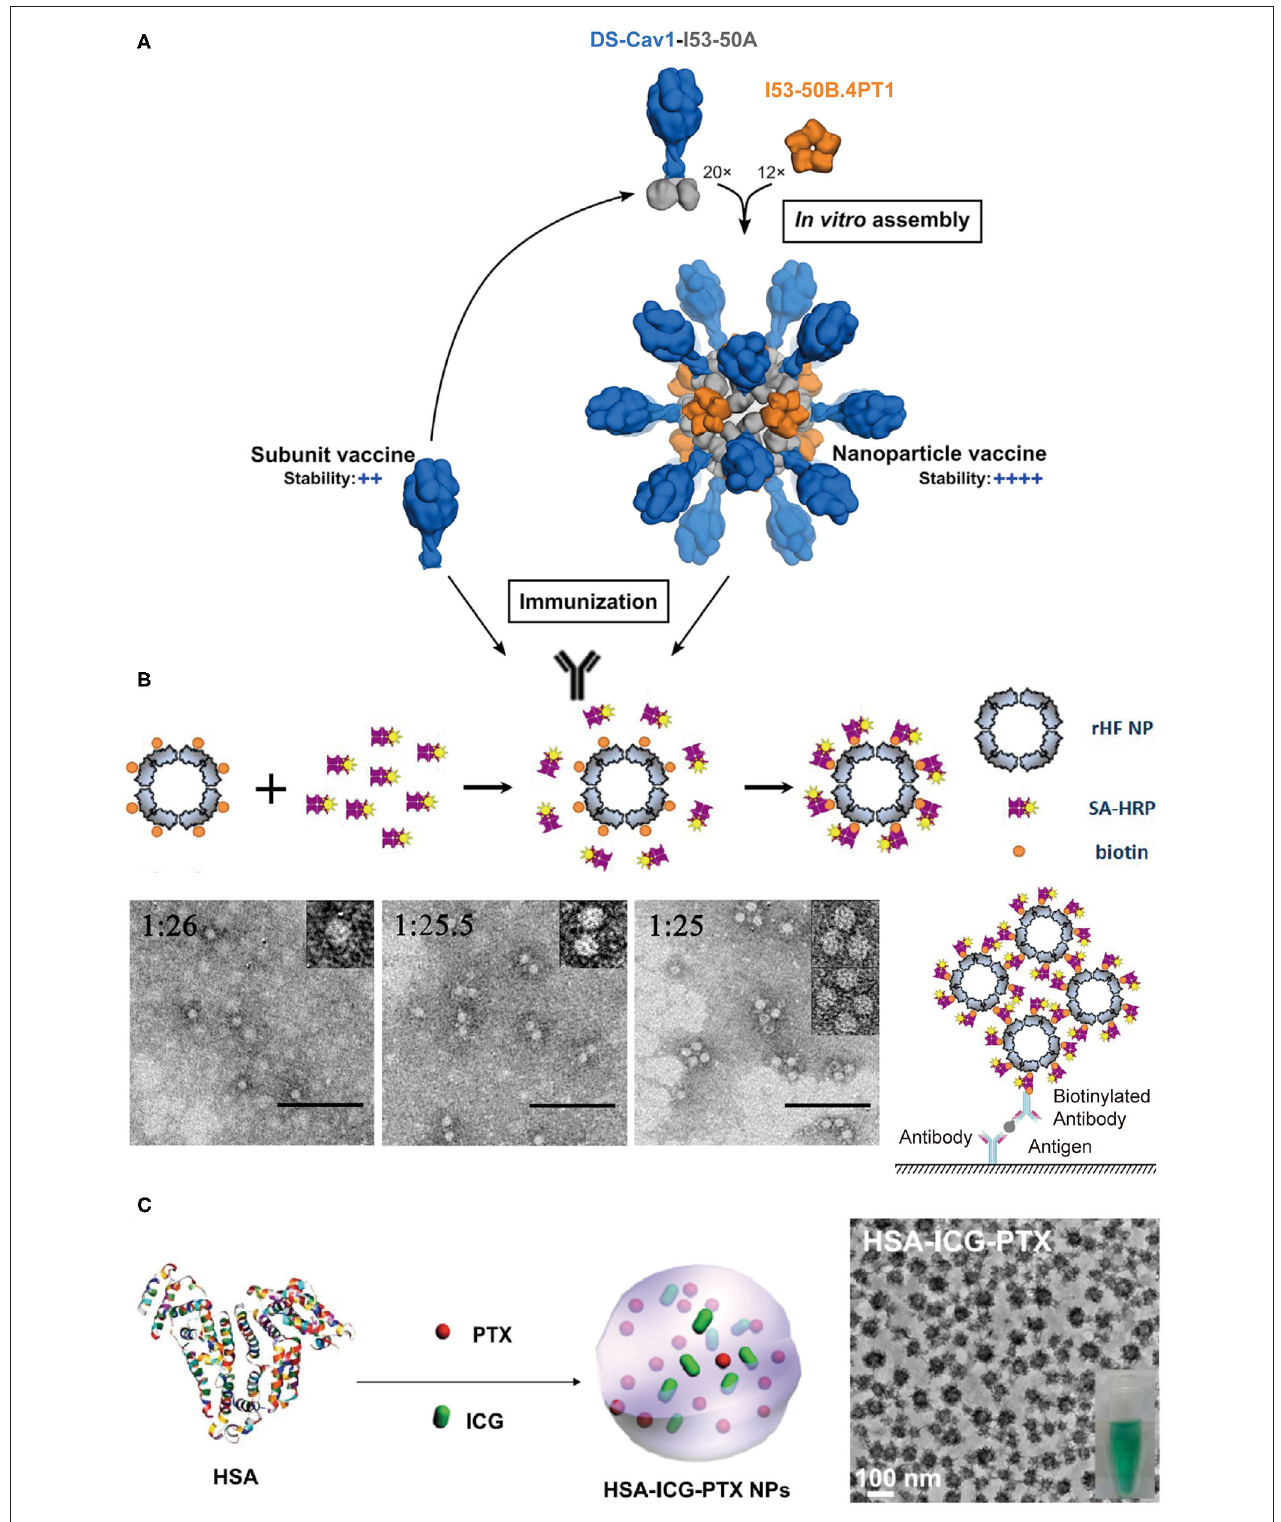
FIGURE 8 | Protein assemblies for medical applications. (A) A schematic illustration of the assembly structure of a DS-Cav1 based nanoparticle vaccine. Adapted with permission from Marcandalli et al. (2019). Copyright 2019 Elsevier Inc. (B) The molecular mechanism proposed for the co-assembly of ENC (top) and the particle geometry of ENC observed in TEM images with different molar ratios of rHF NP to SA-HRP of 1:26, 1:25.5, and 1:25, respectively (bottom). The scale bar is 100nm in each TEM images. Reproduced with permission from Men et al. (2015). Copyright 2015 American Chemical Society. (C) A schematic illustration of the formation of HSA-ICG-PTX nanoparticles based on the co-assembly of HSA, PTX, and ICG. Adapted with permission from Chen et al. (2015). Copyright 2014 WILEY-VCH.